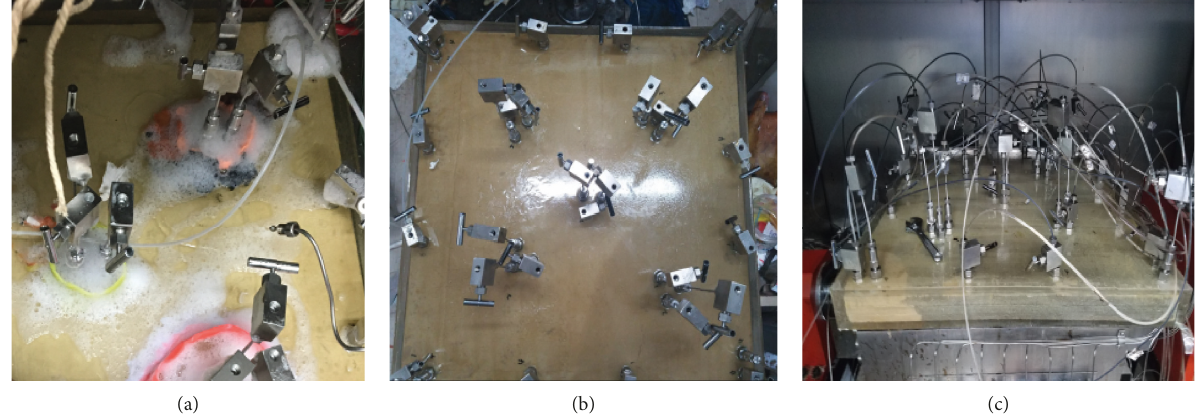
Figure 7: Experiment procedures. (a) Leak detection. (b) Water saturation. (c) Oil saturation.